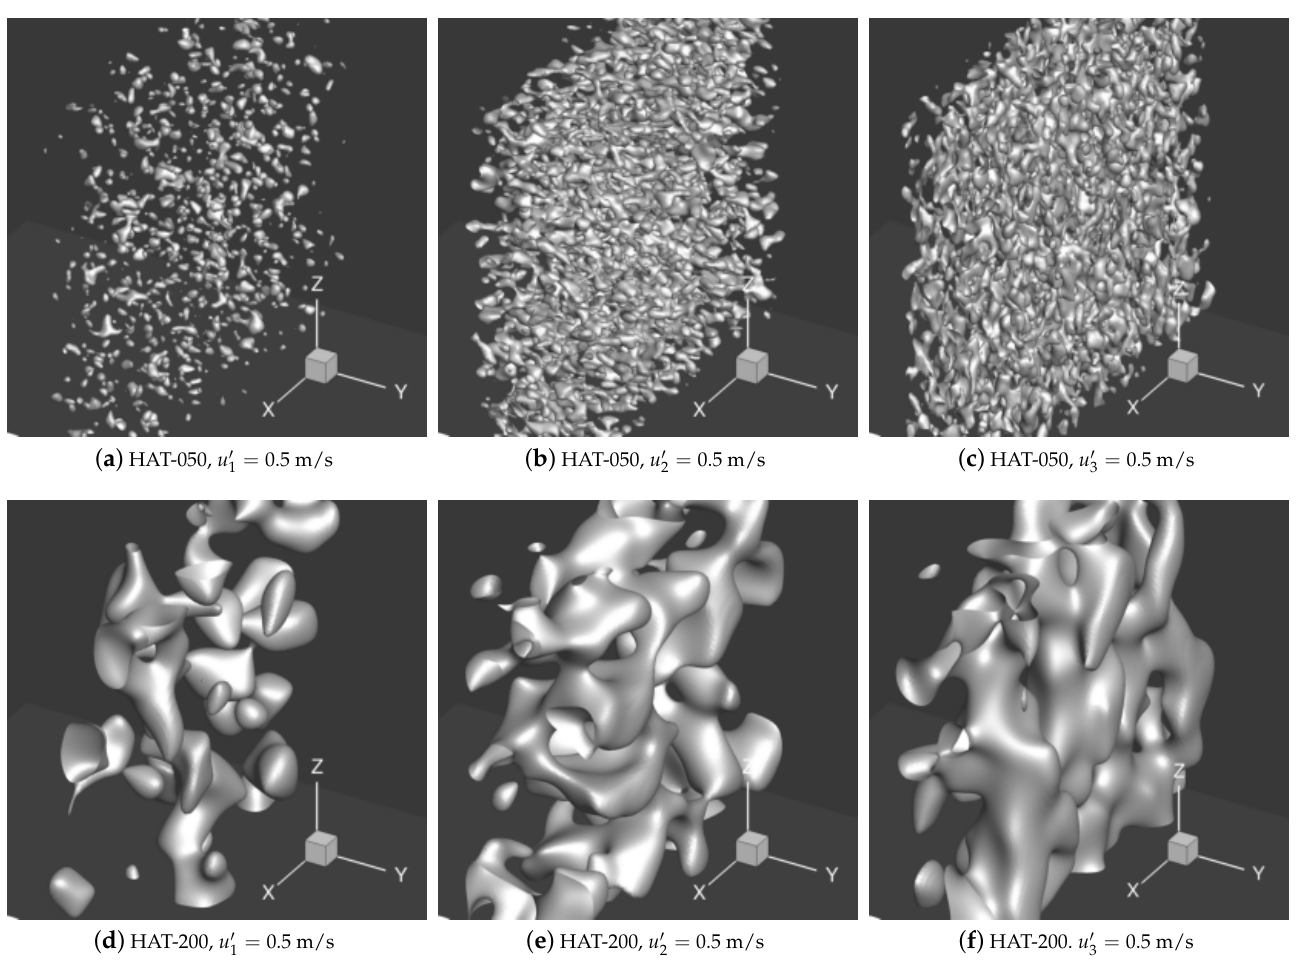
Figure 2. Iso-surfaces of the initial velocity fluctuations in the case homogeneous isotropic turbulence (HIT-200).